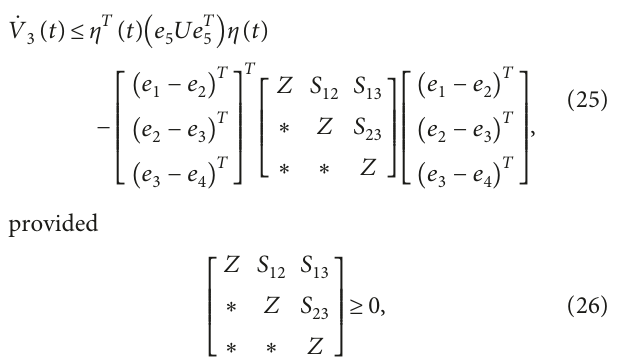
Table 2. The propensity for the curve to progressively di- minish with the rise of K can be seen in Figure I